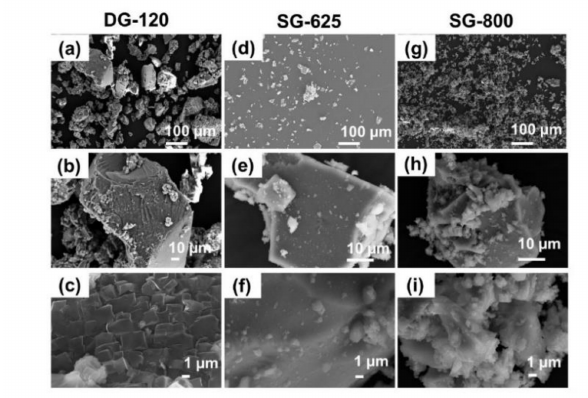
Figure 4. SEM morphological evaluation of DG-120 ( a – c ), SG-625 ( d – f ) and SG-800 ( g – i ) sol-gel-derived powders at di ff erent magnifications.